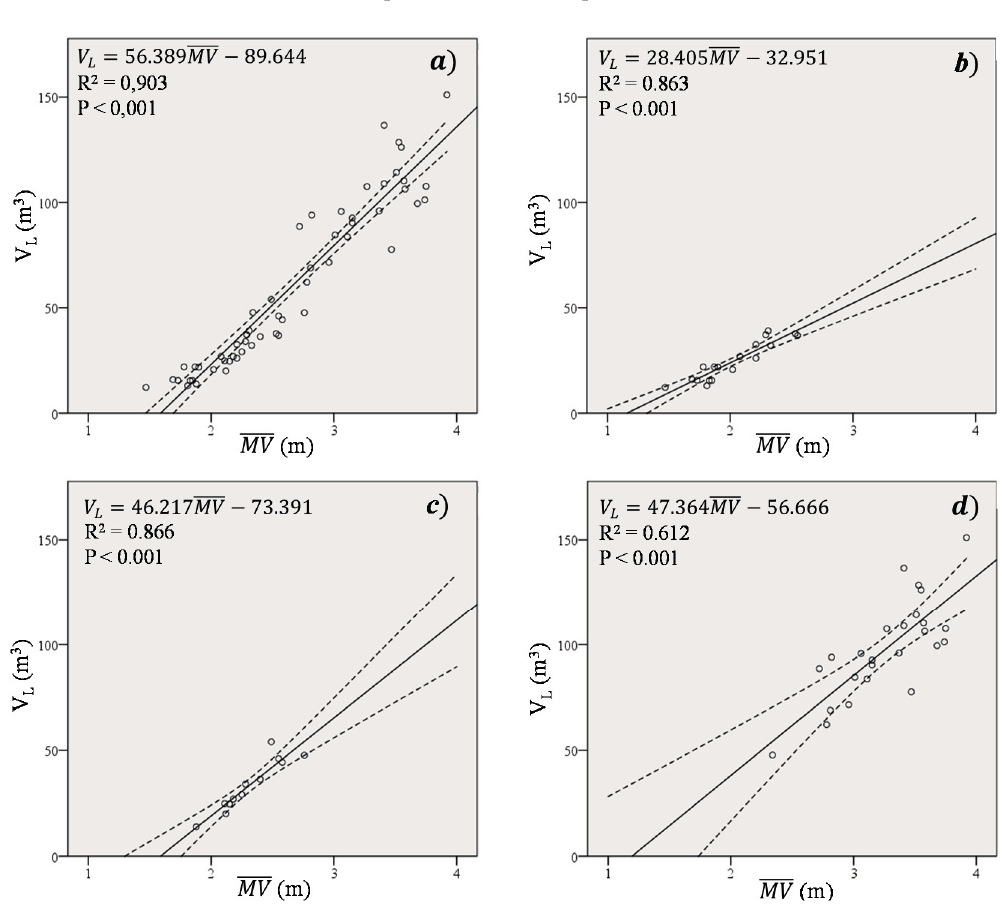
Figure 10. Correlations between (cid:1839)(cid:1848)(cid:3364)(cid:3364)(cid:3364)(cid:3364)(cid:3364) and LiDAR volume for ( a ) All studied trees; ( b ) Intensive trees; ( c ) Adapted traditional trees; ( d ) Traditional